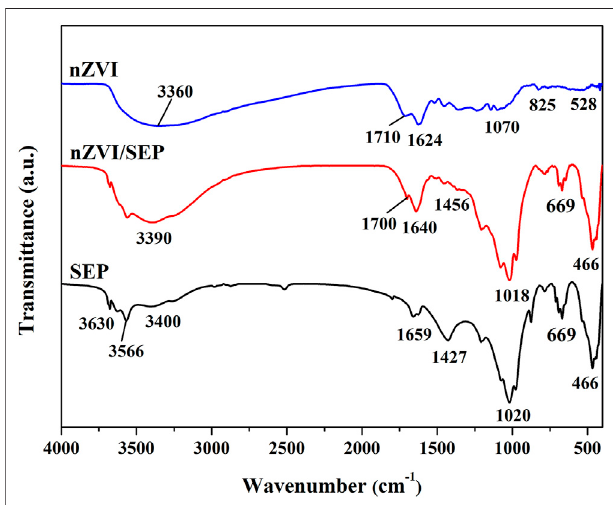
FIGURE 5 | XPS spectra of (A) full-range scan spectra of nZVI and nZVI/SEP, and (B) Fe 2p, (C) C 1s and (D) O 1s of nZVI/SEP composite.